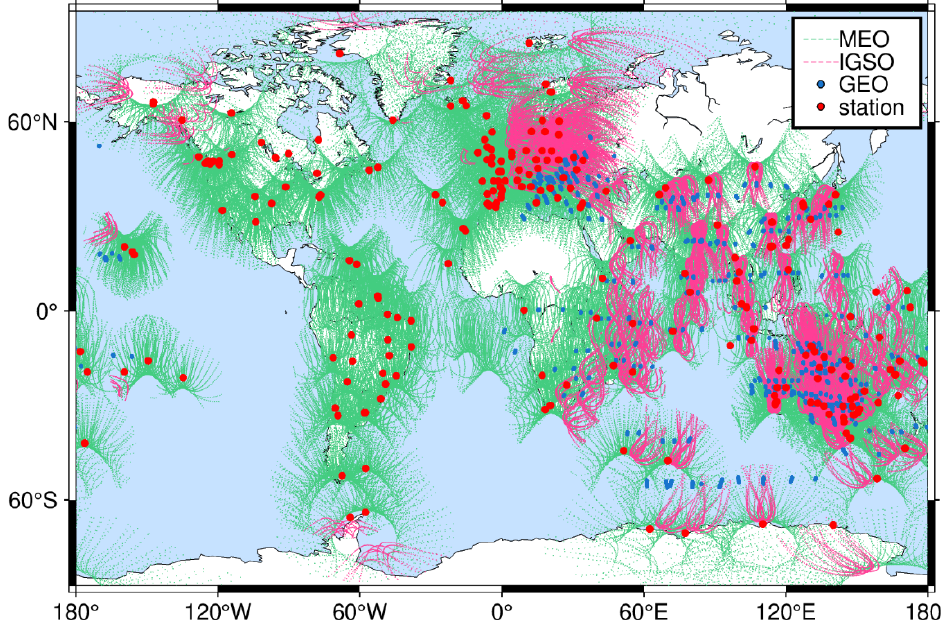
Figure 4. IPPs trajectory distribution of BDS different orbital satellites.